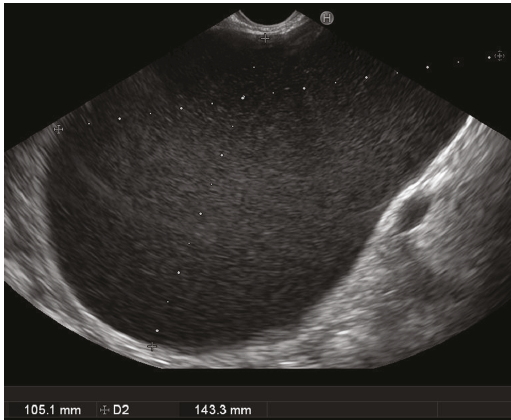
Figure 7: Large pancreatic pseudocyst ( 143 × 105mm ).